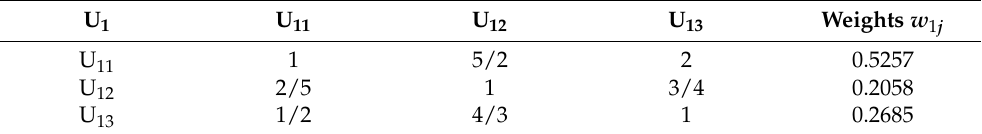
Table 6. Judgment matrix U 1 –U 1 j .